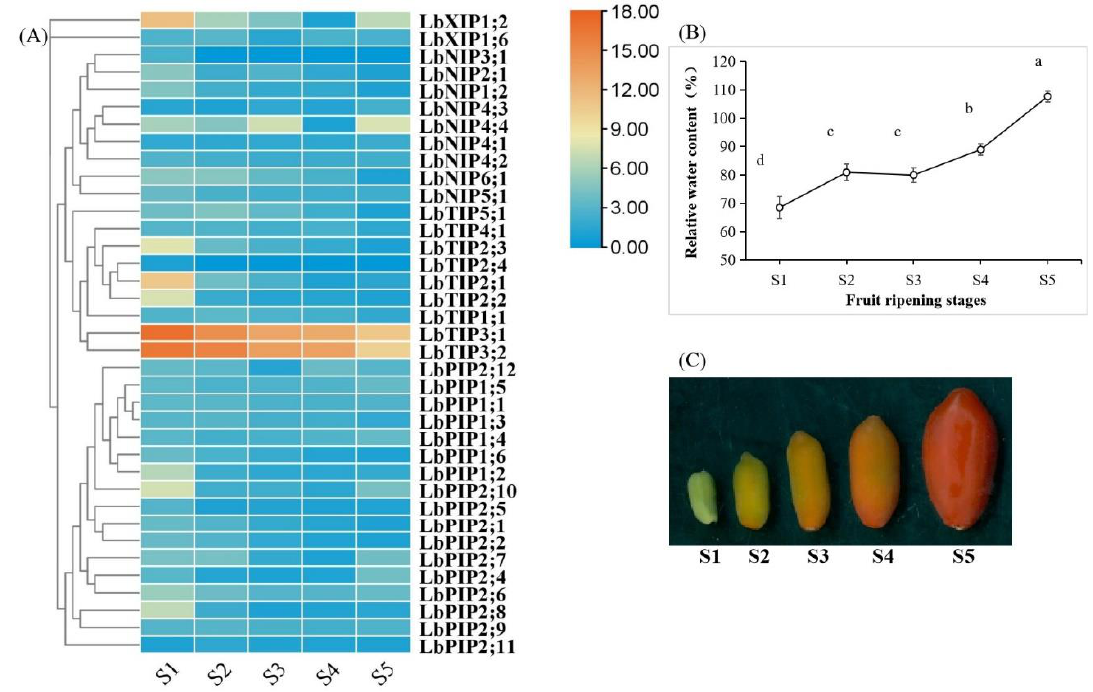
Figure 7. Development-dependent expression profiling during fruit ripening. ( A ) The transcript abundance of LbAQPs during fruit ripening was analyzed at five different developmental stages under their natural state. The fold changes in the relative expression levels were analyzed via the 2 −ΔΔ CT method using the LbACTIN1 gene as an internal control. Values are the means of three independent experiments. ( B ) Relative water content (%) of the fruits for the above five ripening stages. Values represent the mean ± SEM, n = 3 (biological replicates). Means with different letters are significantly different ( p < 0.01; one-sided ANOVA). ( C ) Phenotypes of the five representative ripening stages (S1, S2, S3, S4, and S5) of L. barbarum